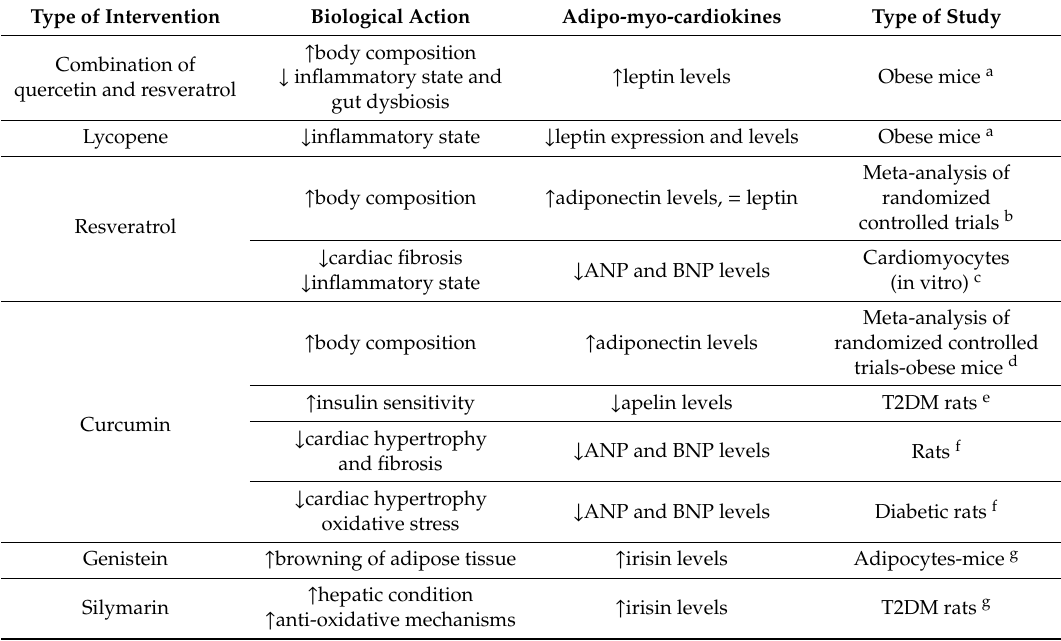
Table 4. E ff ects of polyphenolic supplementation on adipokines, myokines, and cardiokines. Type of Intervention